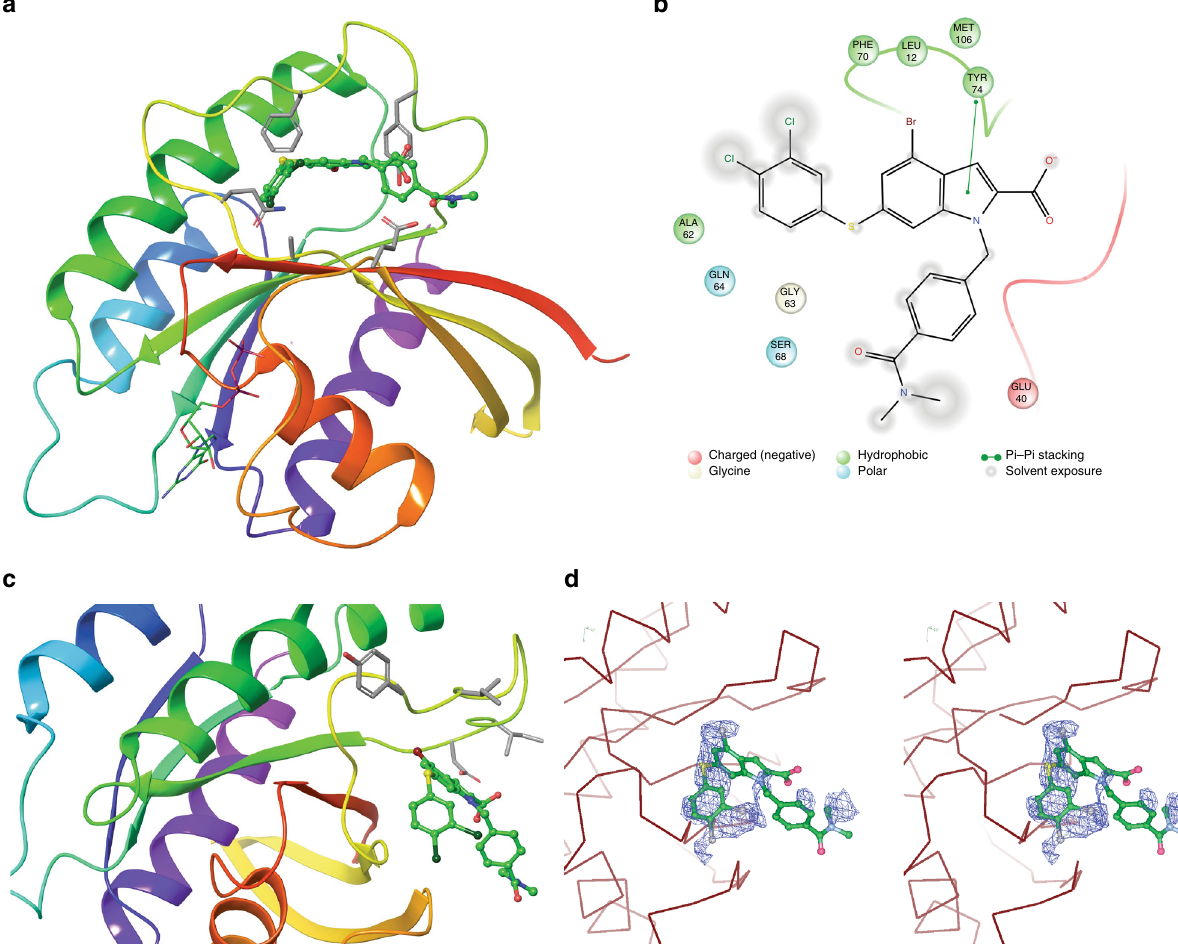
Fig. 3 Biophysical characterization of NR1 . a 2.6 Å X-ray crystal structure of C-terminal truncated Rheb bound to NR1 . Side-chains of residues within 4 Å of NR1 are shown in stick representation. b Ligand interaction diagram of NR1 bound to Rheb; side-chains of residues within 4 Å of the ligand are shown. c Another view of the X-ray structure of NR1 bound to Rheb; side-chains of residues implicated in activating mTORC1 are shown. d Stereo image of NR1 bound to